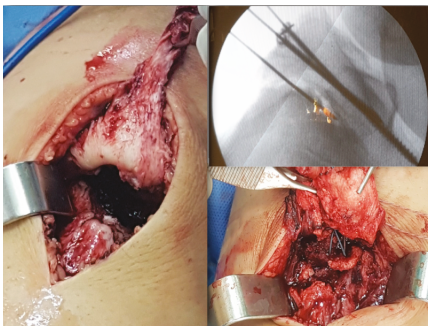
Figure 2: Intraoperative pictures showing approach and radiological control